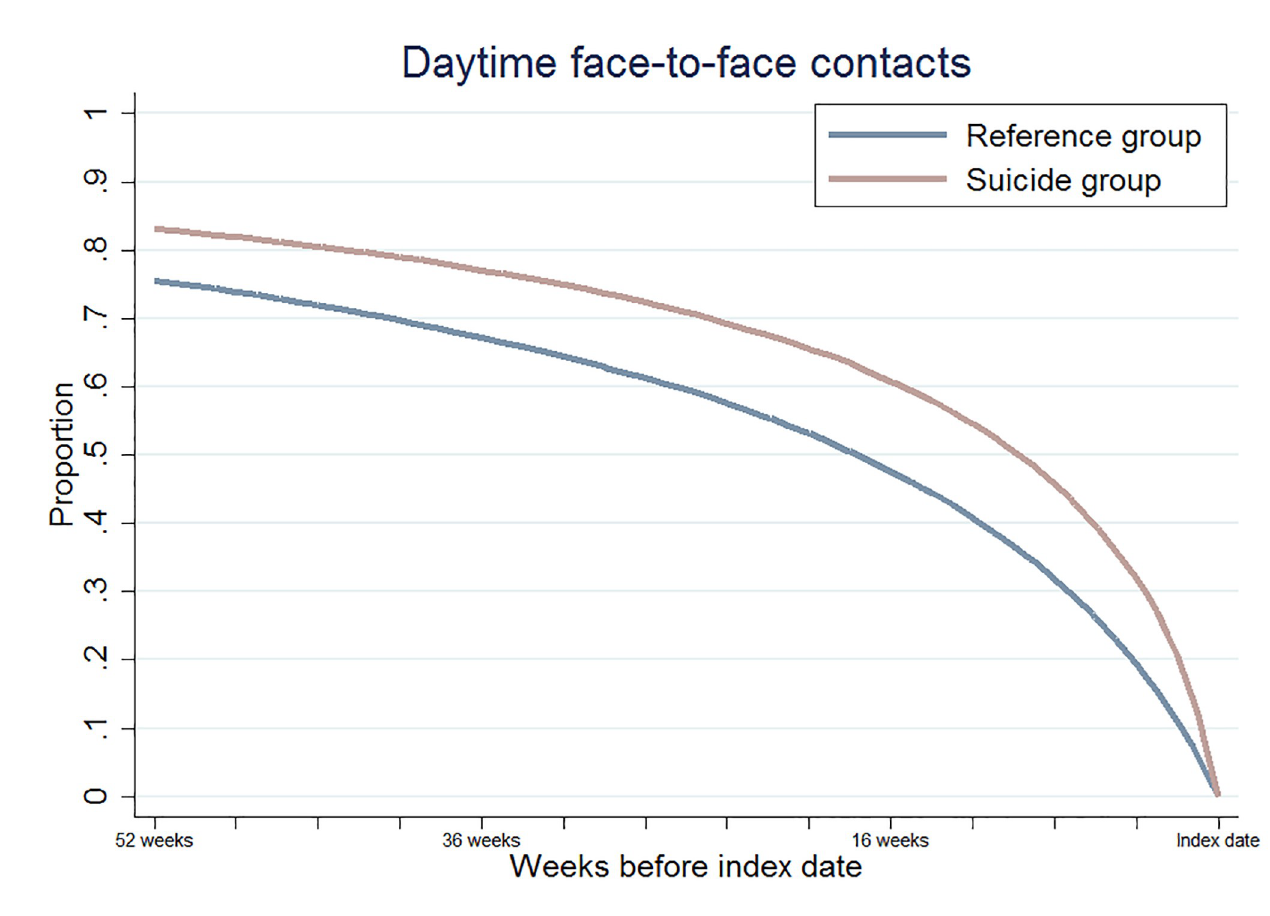
Fig 1. Backwards cumulative proportion of time of last daytime face-to-face contact before index date.